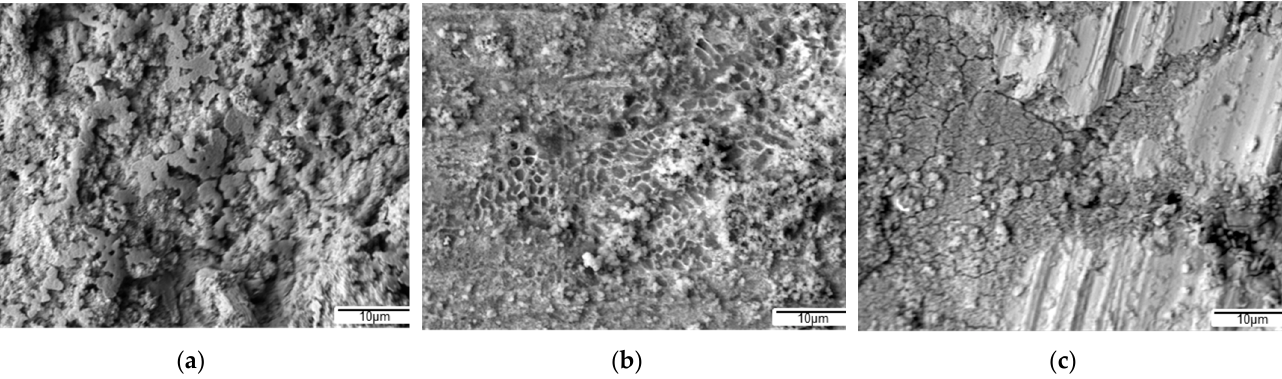
Figure 13. The SEM micrographs of surface of the Fe 62 Co 15 B 14 Si 9 ( a ), Fe 67 Co 10 B 12 Si 9 Nb 2 ( b ), and Fe 57 Co 10 B 20 Si 5 Nb 4 V 4 ( c ) alloys after the corrosion test.